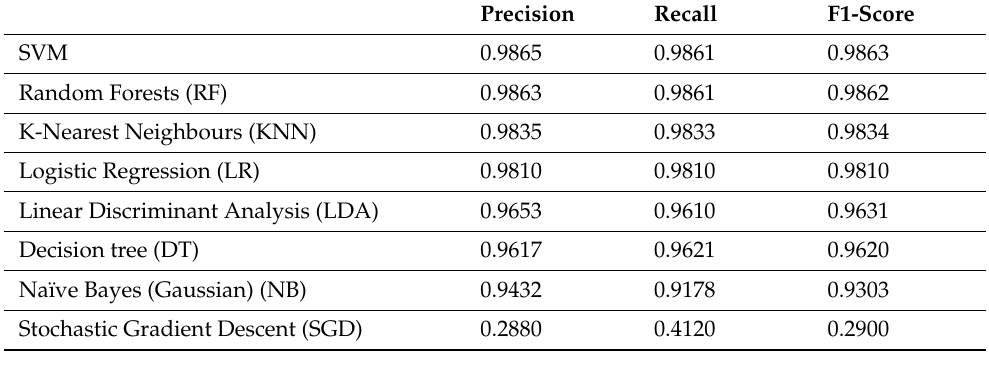
Table 3. Precision, Recall, and F 1-score Measures for Classifiers Comparison, in descent order regarding P-R-F1 measures.